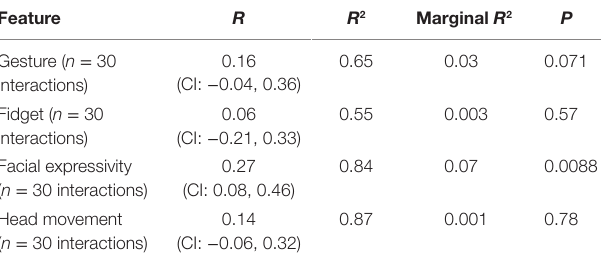
TaBle 5 | Mixed effects correlations between interlocutors’